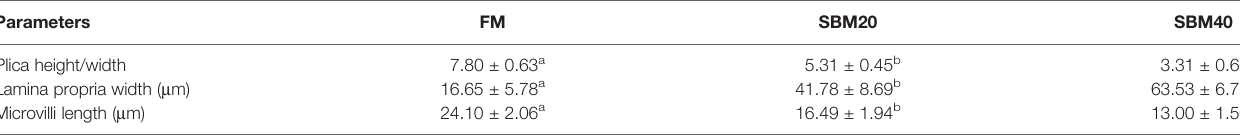
TABLE 3 | The enteritis index in H&E sections of pearl gentian grouper distal intestine tissues ( n = 10). Parameters